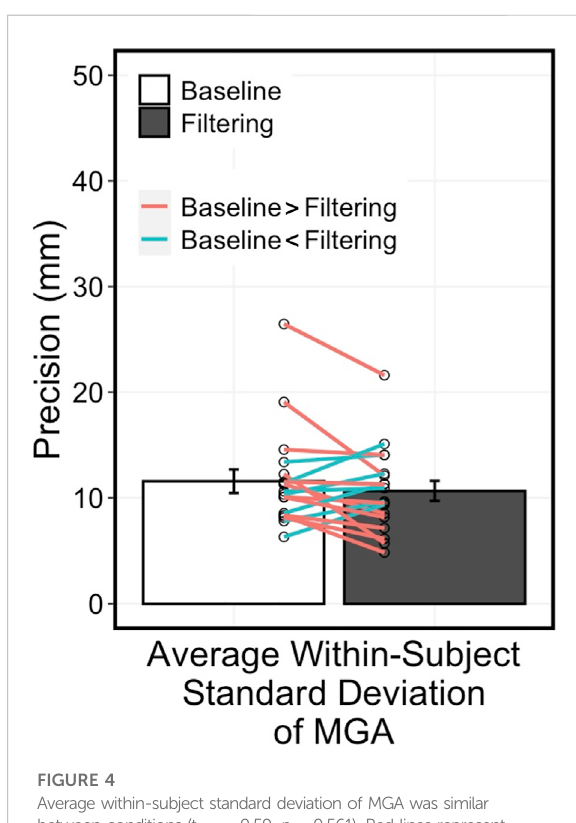
FIGURE 4 Average within-subject standard deviation of MGA was similar between conditions (t 17 = − 0.59, p = 0.561). Red lines represent individualswithRTgreaterinbaselineconditionthanin fi lteringcondition and blue lines represent individuals with RT greater in fi ltering